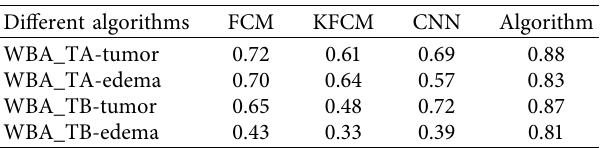
Figure 3: Dice coefficient metrics for image segmentation. Table 2: The mean value of the dice coefficient measurement of each segmentation algorithm.